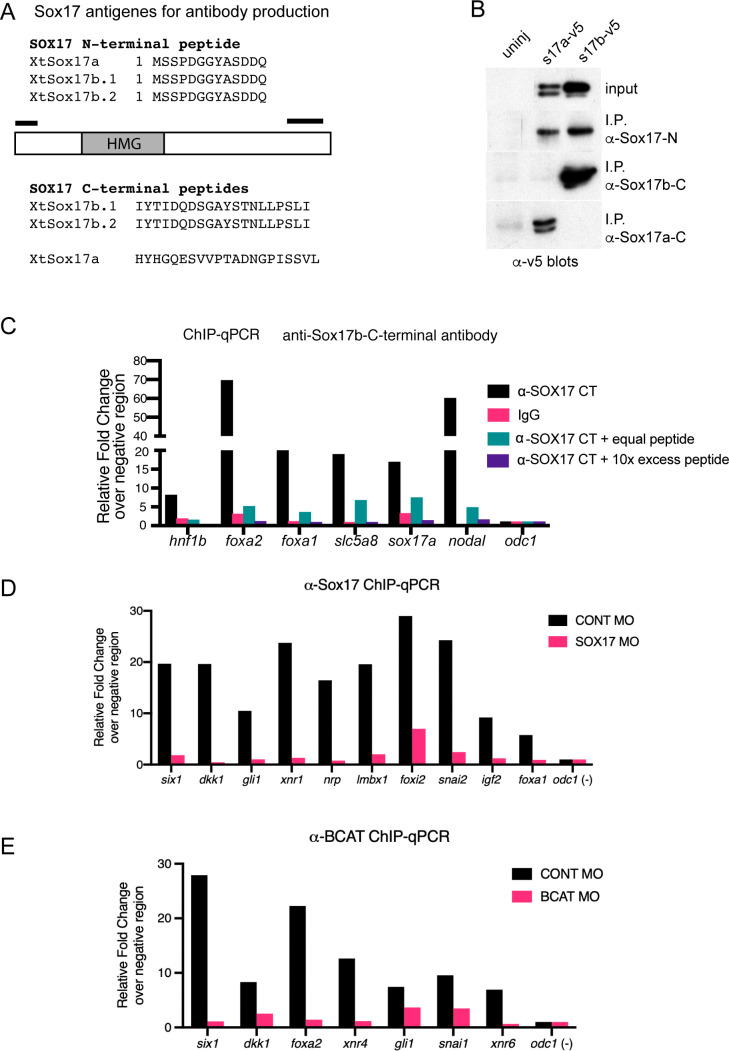
Validation of ChIP antibodies.(A) Schematic and amino acid sequences of the Xenopus tropicalis Sox17 peptides used to immunize rabbits and generate polyclonal antibodies to: pan-Sox17 N-terminal, Sox17b Cterminal and Sox17a C-terminal. (B) Immunoprecipitation of Xenopus laevis embryos expressing V5 epitope-tagged versions of Sox17a-V5 and Sox17b1-V5. Anti-V5 western blot showed that all antibodies specifically immunoprecipitated the target antigen but that the Sox17b C-terminal antibody was the most efficient. (C) ChIP-qPCR validation of anti-Sox17 antibodies on previously known target loci. In preliminary ChIP-qPCR experiments, the pan-Sox17 N-terminal and Sox17b C-terminal antibodies bound to all the same loci, but the Sox17b C-terminal antibody showed higher fold enrichment (data not shown) and was used for ChIPseq experiments. Representative ChIP-qPCR results show relative fold change of Sox17b binding versus IgG control in Sox17-bound positive control loci relative to the negative control region of odc1,. Addition of the Sox17b C-terminal peptide reduced the ChIP signal in a dose-dependent manner indicating specific binding. (D) Representative ChIP-qPCR assessing the efficiency of Sox17MO knockdown. Sox17 enrichment at target loci are shown relative to a negative region (odc1) in embryos injected with either control-MO or Sox17-MO. The Sox17-MO dramatically reduces Sox17 occupancy at all loci. (E) Representative ChIP-qPCR assessing the efficiency of Bcat-MO knockdown. Bcat enrichment at target loci are shown relative to a negative region (odc1) in embryos injected with either controlMO or Bcat-MO. The Bcat-MO dramatically reduces its occupancy at all loci. All ChIP-qPCR experiments were repeated at least twice.